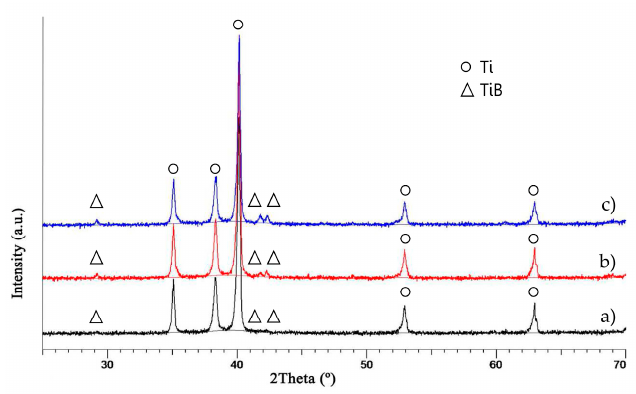
Figure 6. XRD patterns of composites manufacture at 1100 °C for 15 min via iHP with different % volume of B: ( a ) 0.9 vol %; ( b ) 2.5 vol %; and ( c ) 5 vol %.